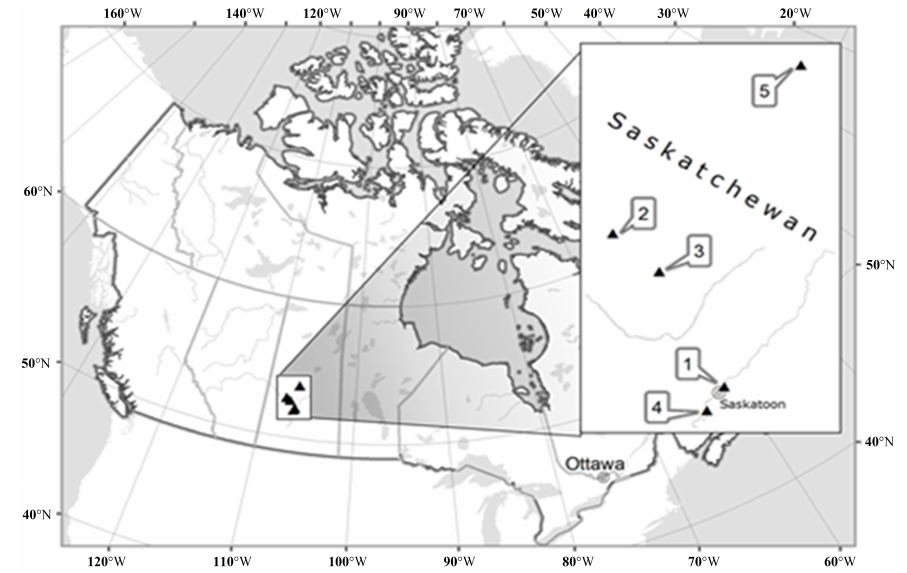
Figure 8. Locations of the study populations of Anemone patens in Saskatchewan, Canada: 1—Crocus Prairie Conservation Area, 2—Battlefords Provincial Park, 3—Redberry Lake Biosphere Reserve, 4—Cranberry Flats Conservation Area, 5—Prince Albert National